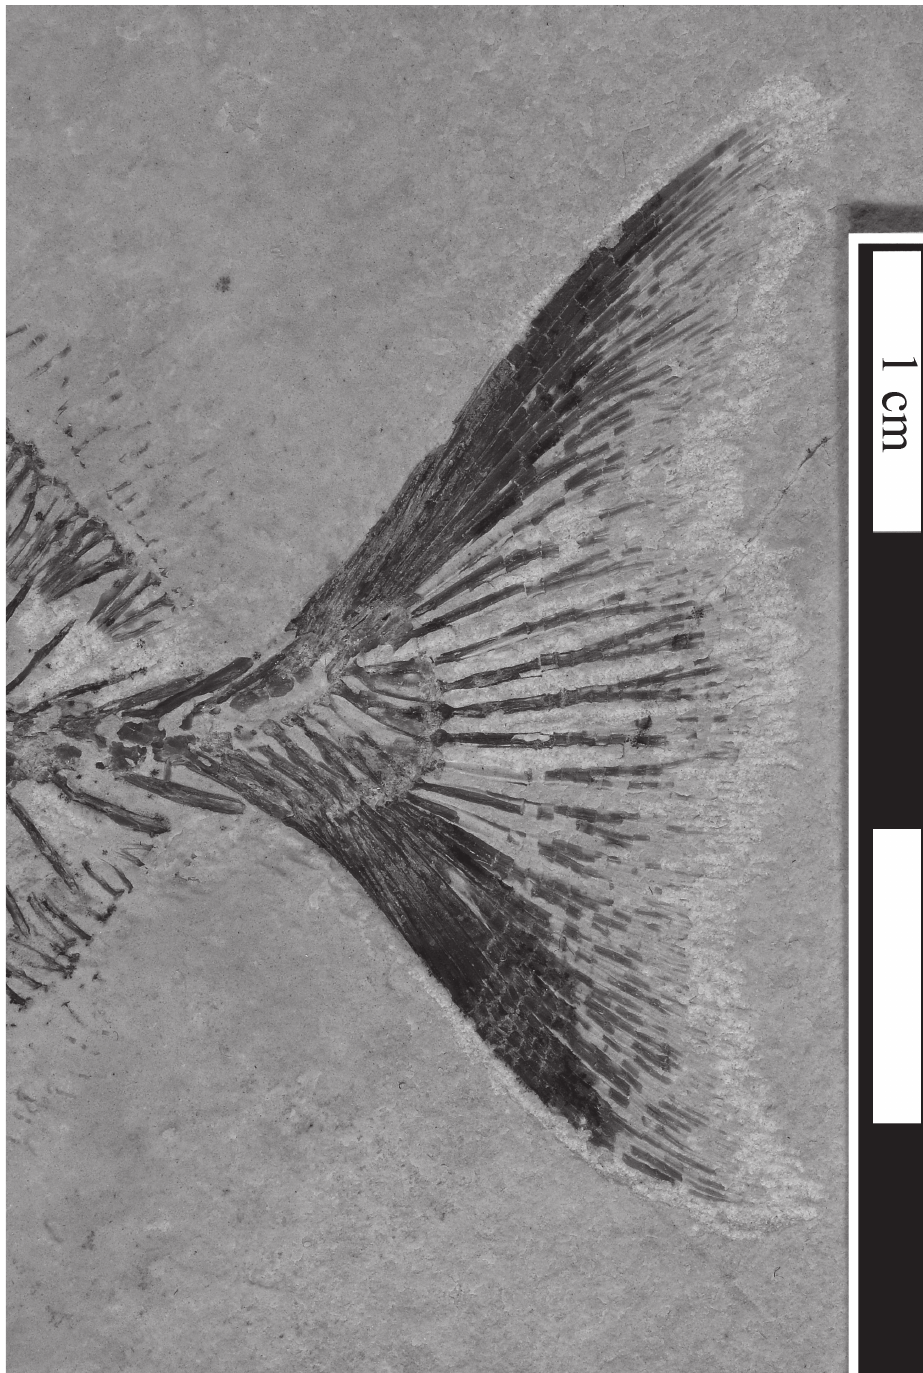
Fig. 13. Acrorhinichthys poyatoi gen. et sp. nov. Caudal region of the holotype CLC